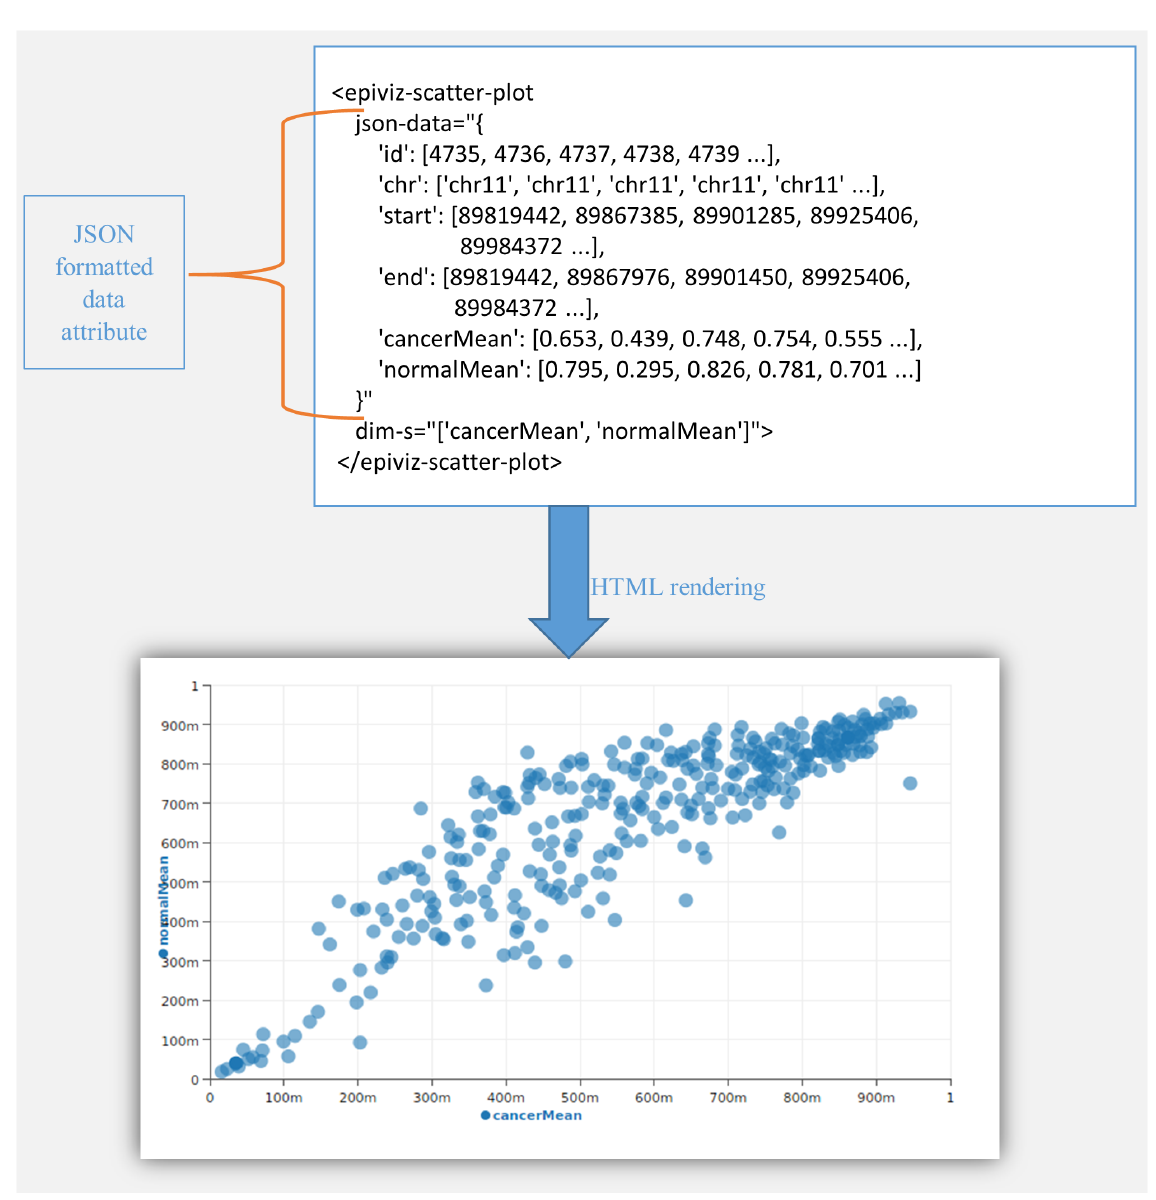
Figure 2. Example using components in HTML page. Epiviz components can be inserted in any HTML page using tags defined by the component library (e.g., epiviz-json-scatter-plot in this example). Data is supplied to the chart via the json-data attribute of the HTML tag.